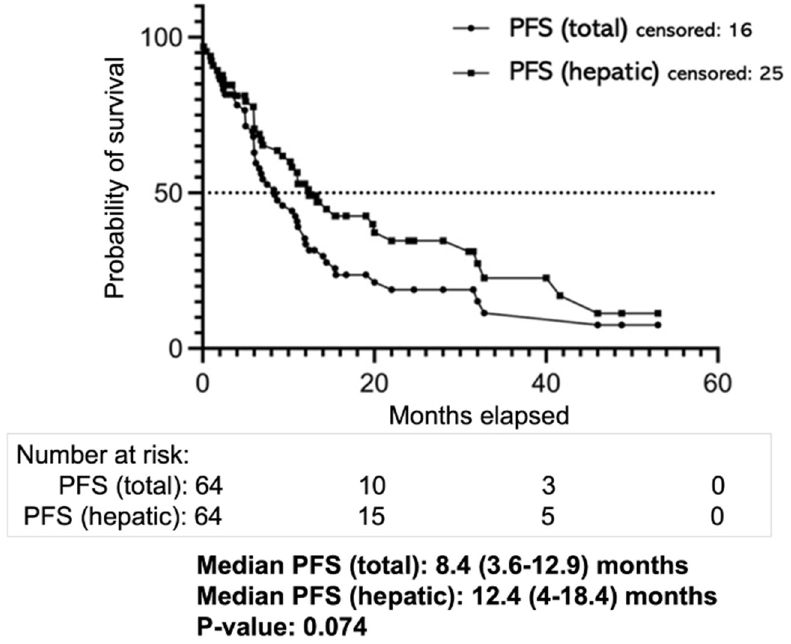
Figure 4. Overview of progression-free survival (PFS). Response assessment: total (overall) and hepatic progression-free survival (PFS) times since the first percutaneous hepatic perfusion (PHP).